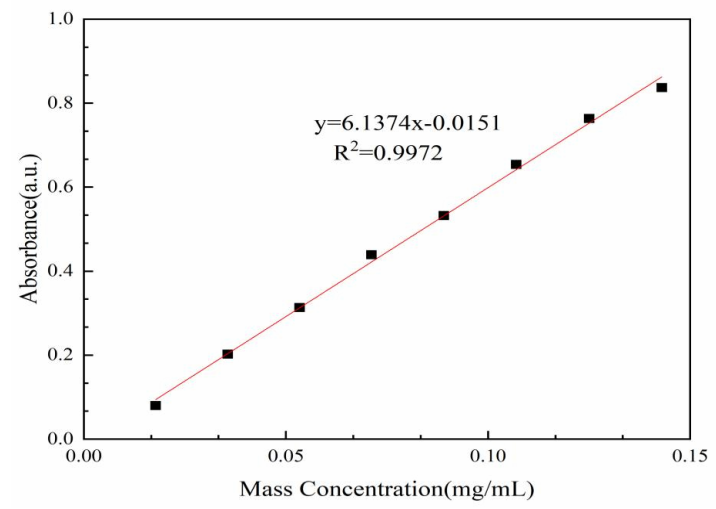
Figure 1. Standard curve of standard C. oleifera saponins by UV spectrophotometry.